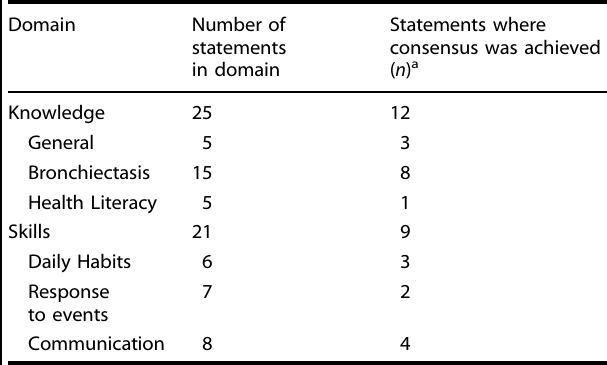
Table 1. Summary of Round 1